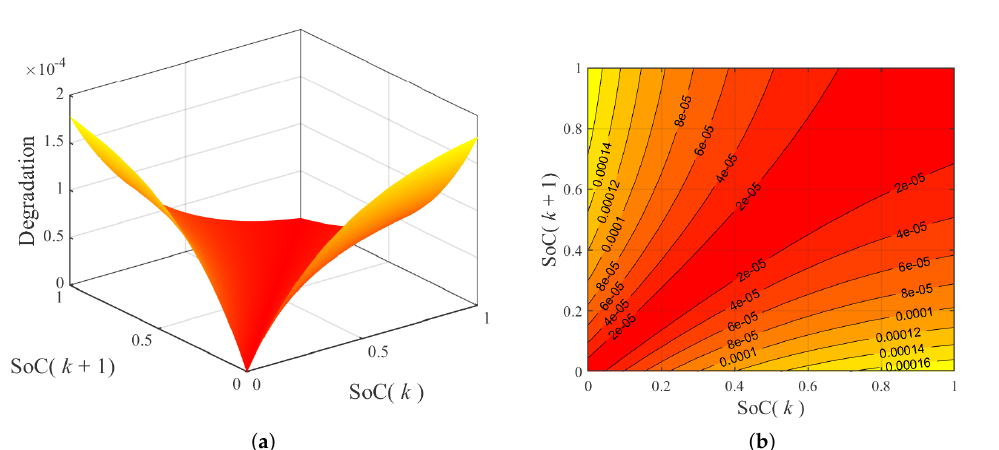
Figure 3. Degradation of lithium-ion batteries as a function of subsequent SoC: surface plot ( a ) and contour plot ( b